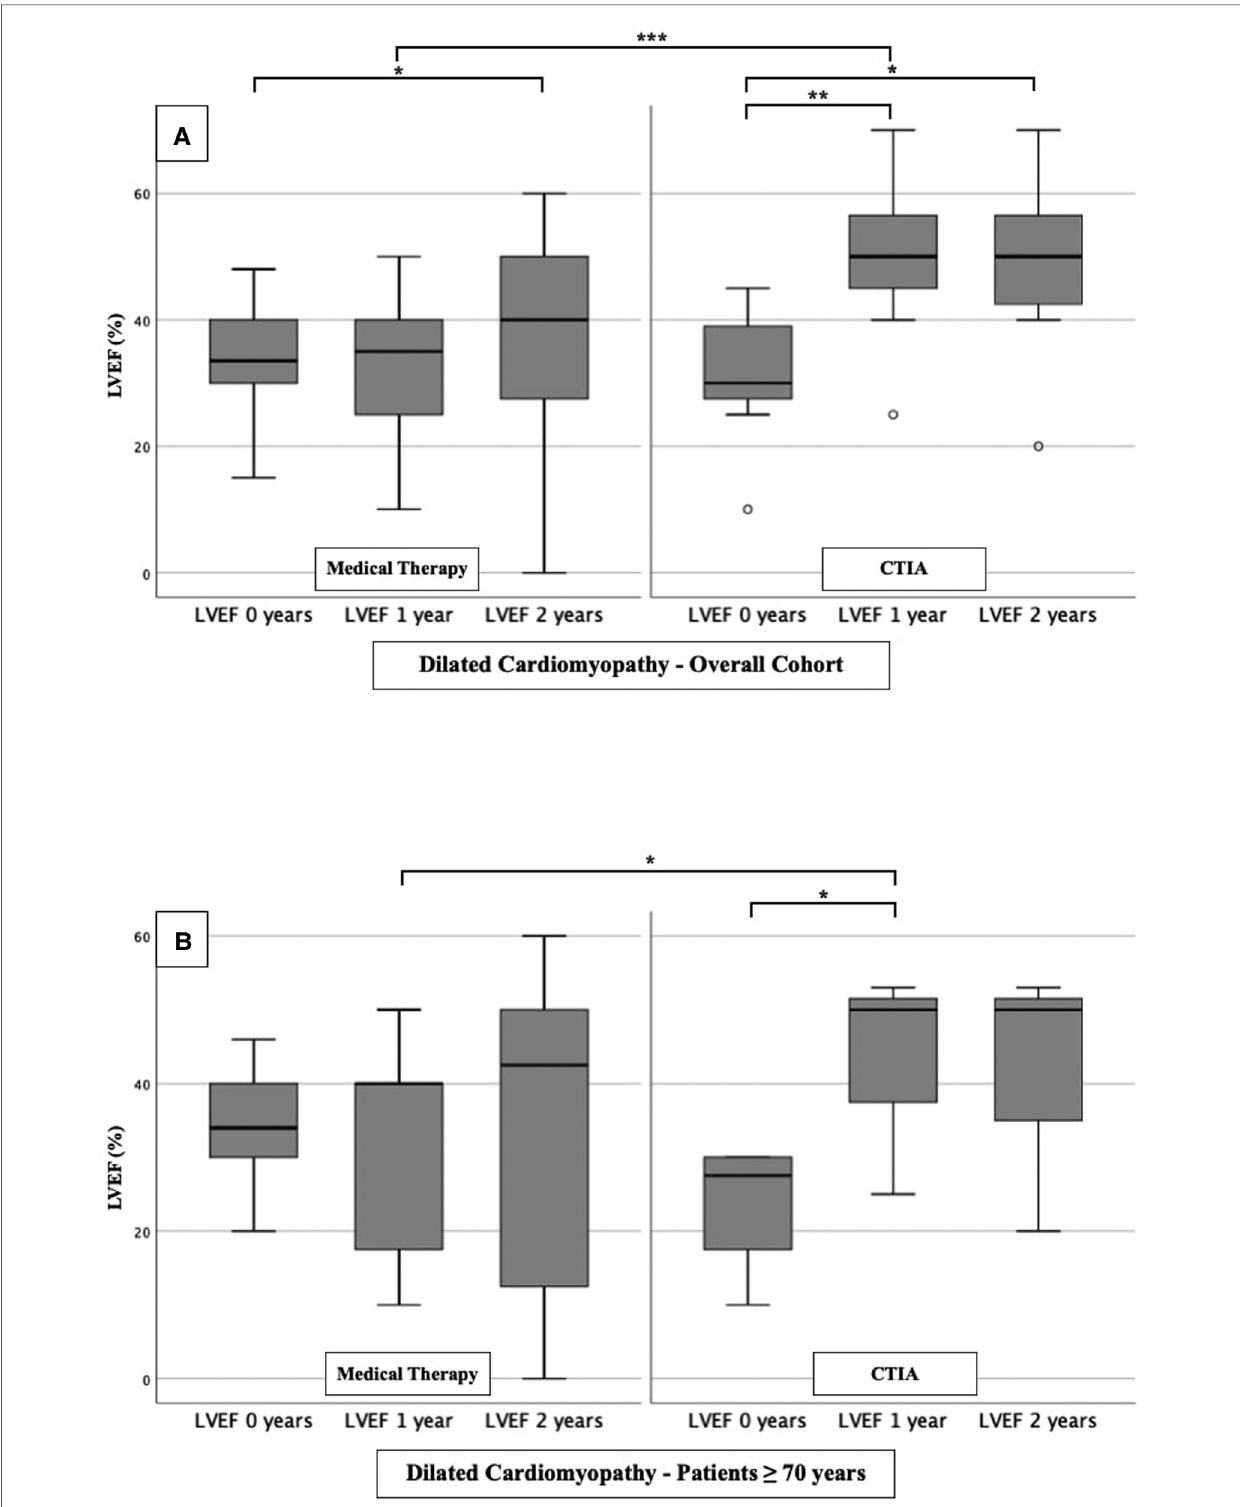
FIGURE 4 LVEF modi fi cations in medical therapy group vs. ablation group of patients with dilated cardiomyopathy. ( A ): All patients with dilated cardiomyopathy. ( B ): Patients ≥ 70 years with dilated cardiomyopathy. * p ≤ 0.050; ** p ≤ 0.010; *** p ≤ 0.001.